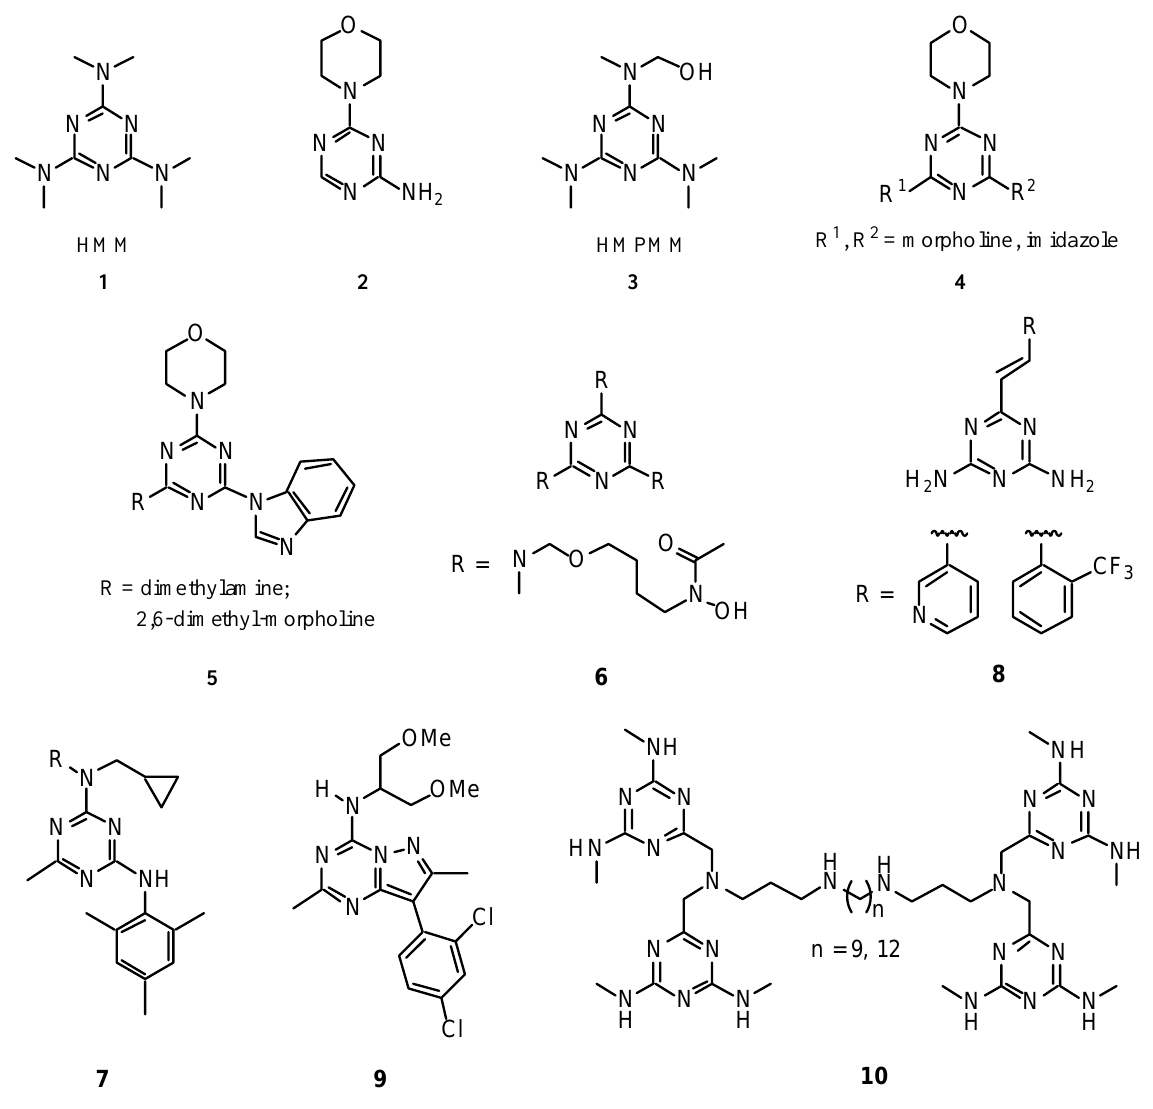
Figure 1. Select examples of biologically active compounds containing the 1,3,5-triazine